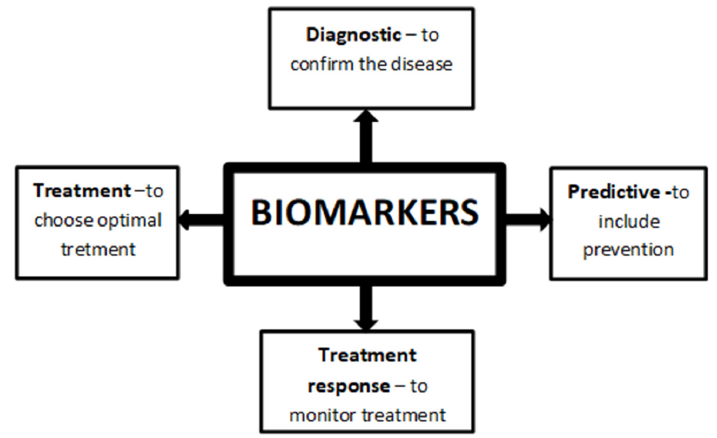
Figure 1. Application of biomarkers.